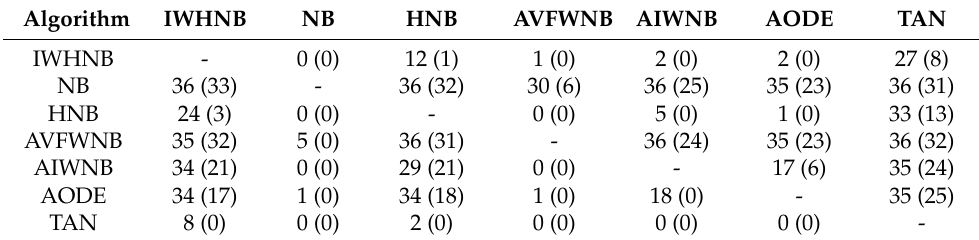
Table 5. Summary test results on elapsed training